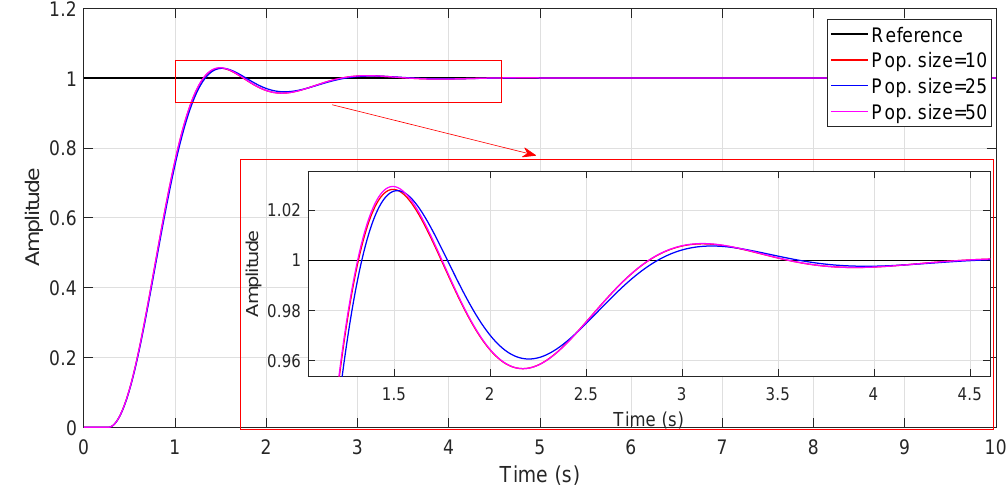
Figure 8. Obtained system responses with different population